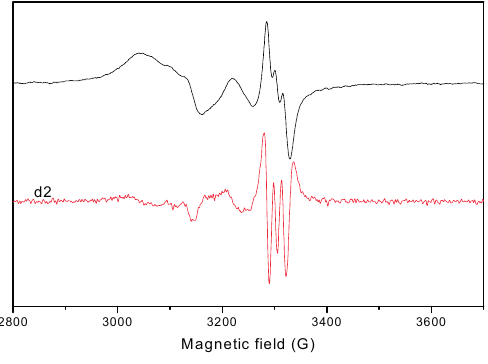
Figure 12. EPR spectrum (the derived signal) for complex 5 in DMSO solution at